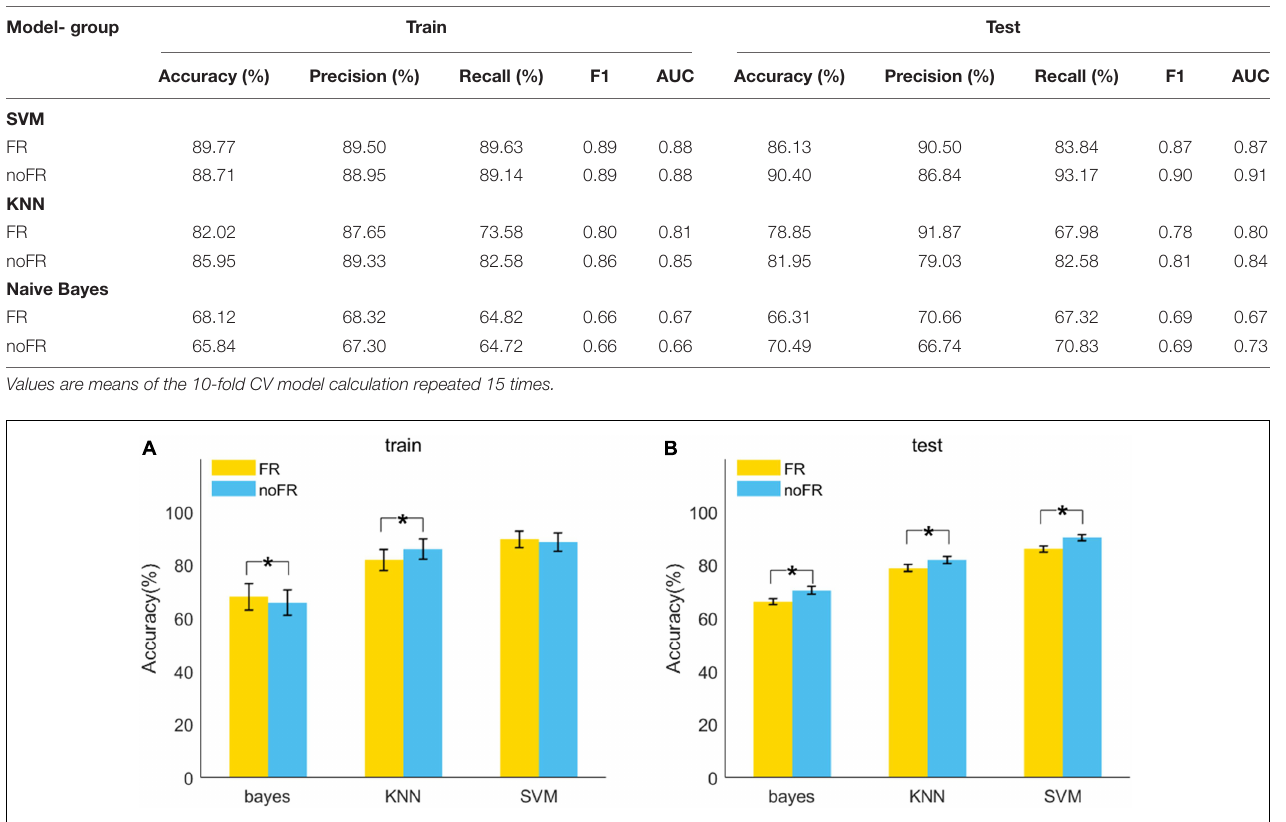
FIGURE 6 | Model accuracy of classification of cue and background condition in 10-fold cross-valid train (A) and test (B) repeated 15 times. Results were obtained by three kinds of models (Bayes, KNN, SVM) based on the whole 384 features data set in two groups (FR, noFR). The error bars are standard deviations. * p <